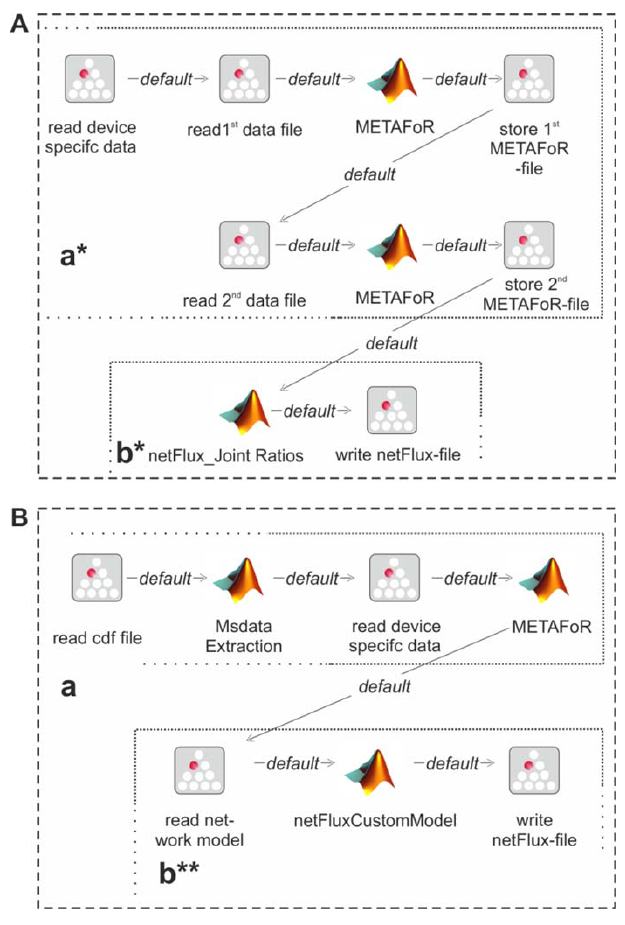
Figure 4. Alternative Flux-P workflows enabling the combined analysis of complementary 13 C data sets (A) and the use of custom network models